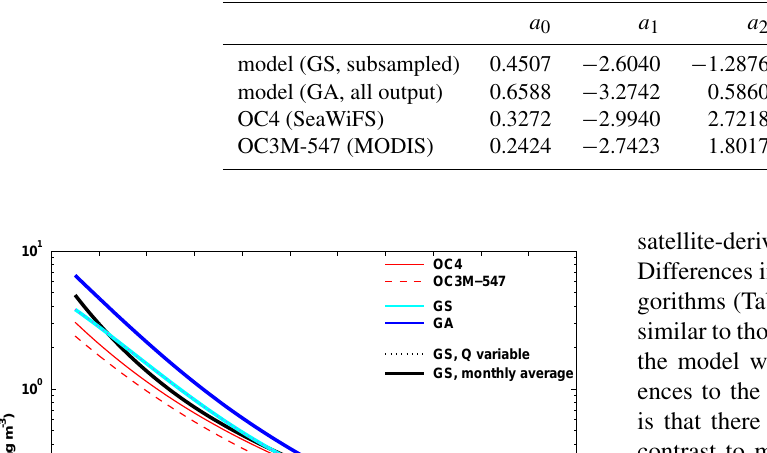
Table 1. Coefficients for global model derived algorithms (Eq. 1) and for the SeaWiFS and MODIS default algorithms.